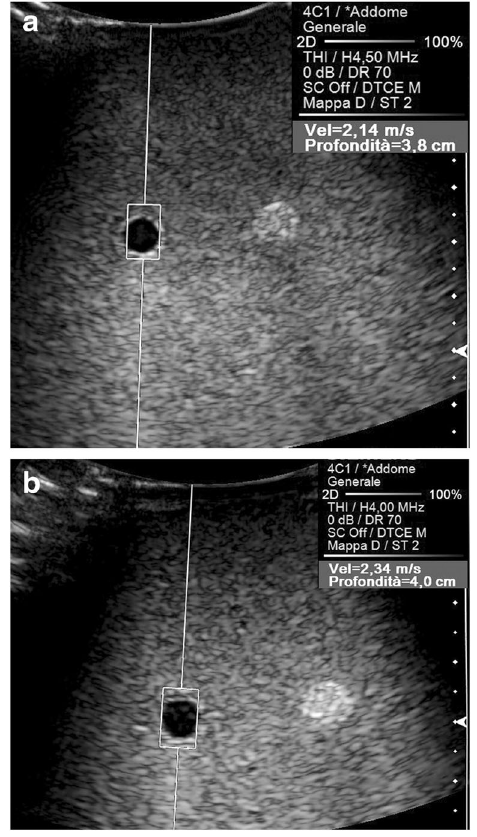
Fig. 3 Effect of the wavelength on the speed of propagation of the shear waves. A lower SWV value (2.14 vs. 2.34 m/s) is attributed to a given target (a sphere of gel included into a phantom) using a 4.5 MHz ( a ) compared to a 4.0 MHz ( b ) transmitting frequency